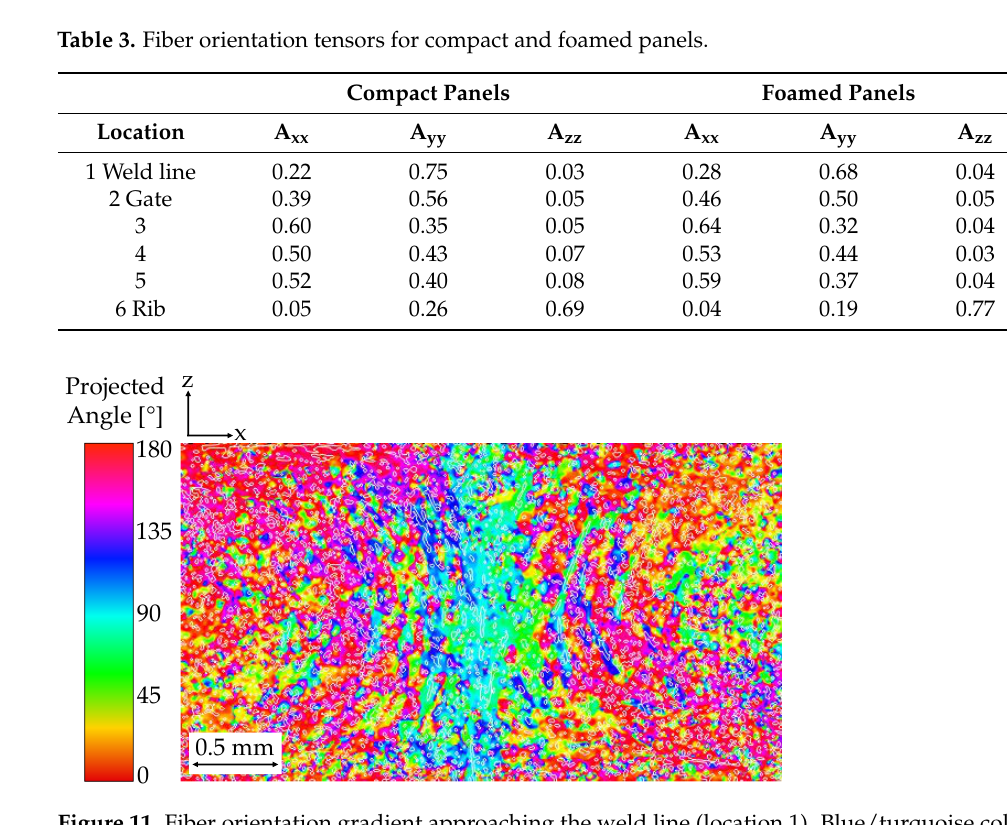
Figure 11. Fiber orientation gradient approaching the weld line (location 1). Blue/turquoise colors indicate increased FO in A YY . Red/pink fibers show alignment in A XX .